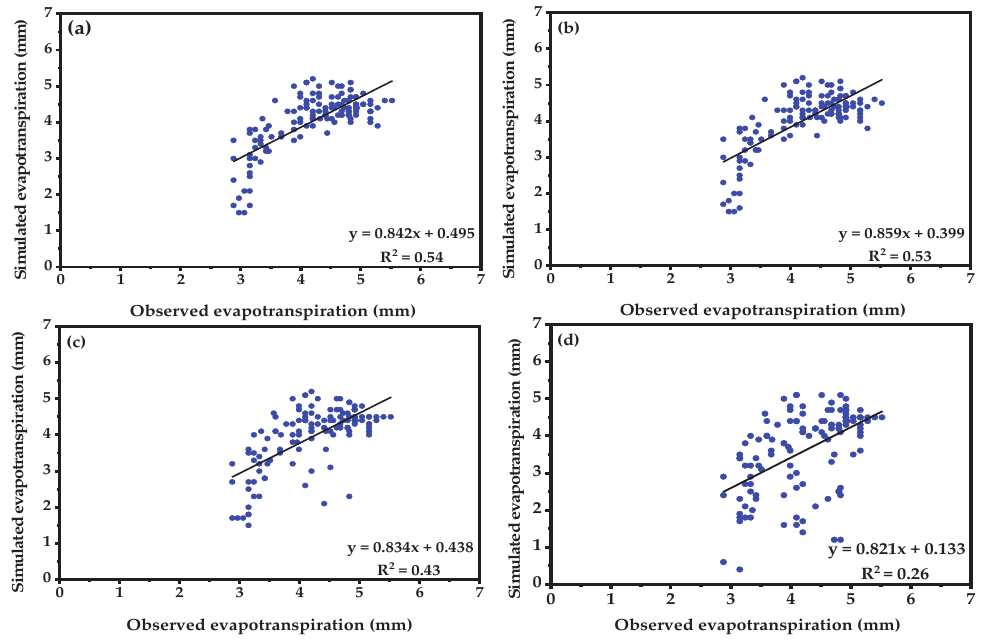
Figure 11. Observed and simulated crop evapotranspiration during the calibration period (2019) under four irrigation regimes. FI, flood irrigation ( a ); 3IF, 3-day irrigation frequency ( b ); 6IF, 6-day irrigation frequency ( c ); and 10IF, 10-day irrigation frequency ( d ). The correlation (R 2 ) between the simulated (y) and observed (x) crop evapotranspiration is considered good (R 2 > 0.5).